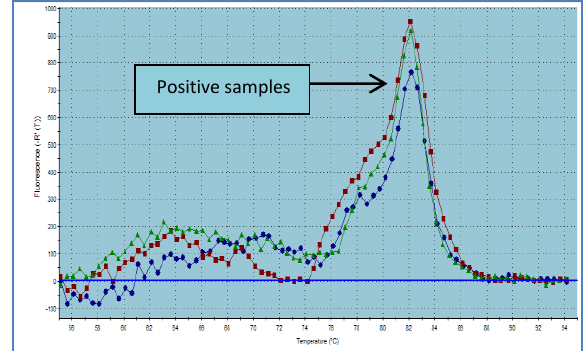
Figure, 2: Dissociation curve for MOMP gene in C. trachomatis , that display a positive DNA samples.